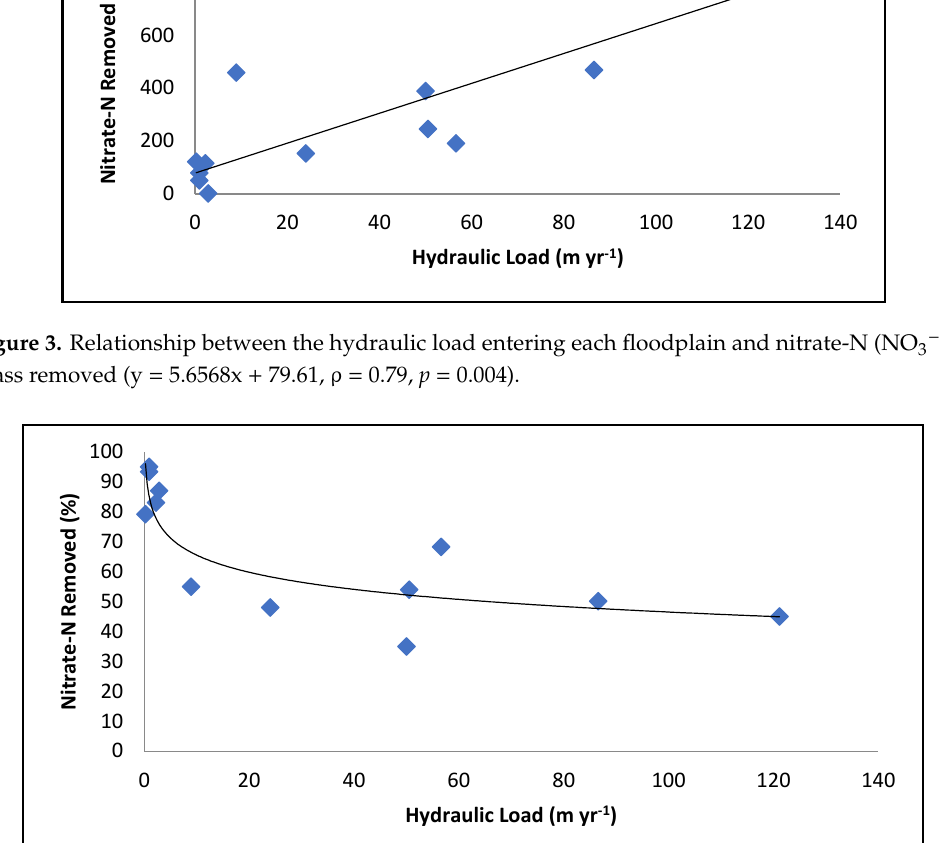
Figure 4. Relationship between the hydraulic load entering each floodplain and percent of nitrate-N (NO 3— N) removed (y = −8.255ln(x) + 84.542, ρ = −0.76, p = 0.007).